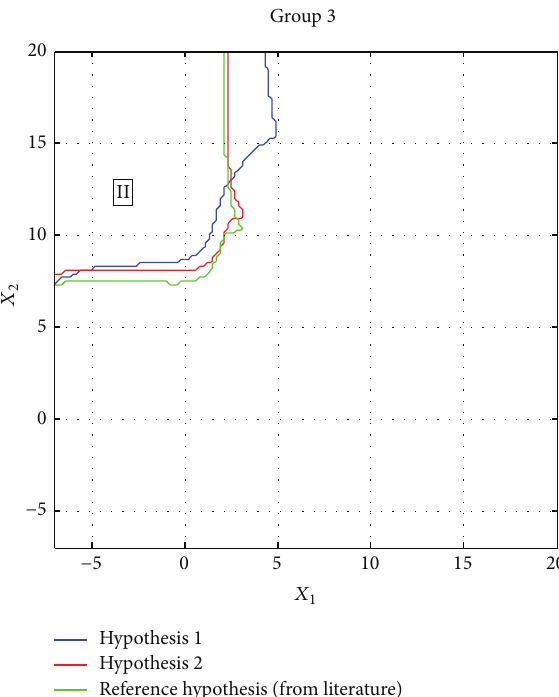
Figure 17: Production policy for 𝑃 1 and setup policy (product 1 to product 2).